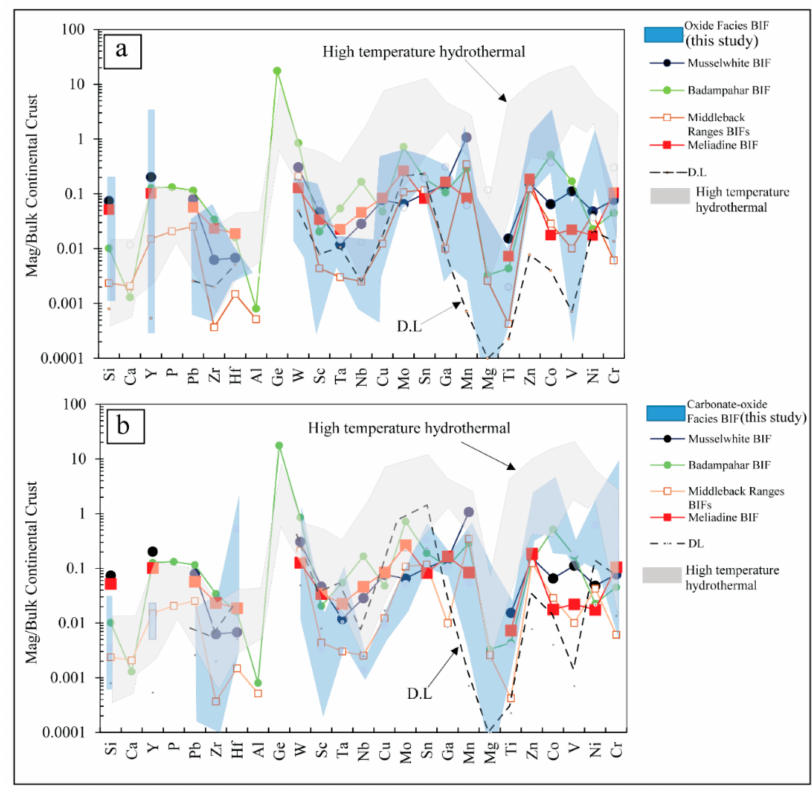
Figure 13. Bulk continental crust (BCC)-normalized multi-element diagrams for the magnetite layers from the Nabeba BIF in comparison with selected BIFs (from Musselwhite, Meliadine [30], Badampahar [31], and Middleback Ranges (Magnet Iron) [33]) (all in situ analysis; [30,31,33]) and high-temperature hydrothermal magnetite [63]: ( a ) oxide facies-BIF magnetite; ( b ) carbonate-oxide facies-BIF magnetite. Blue area in both diagrams denotes elemental concentration of different spots in the Nabeba BIF magnetite layers, and the grey area denotes the elemental concentration of high- temperature hydrothermal magnetite